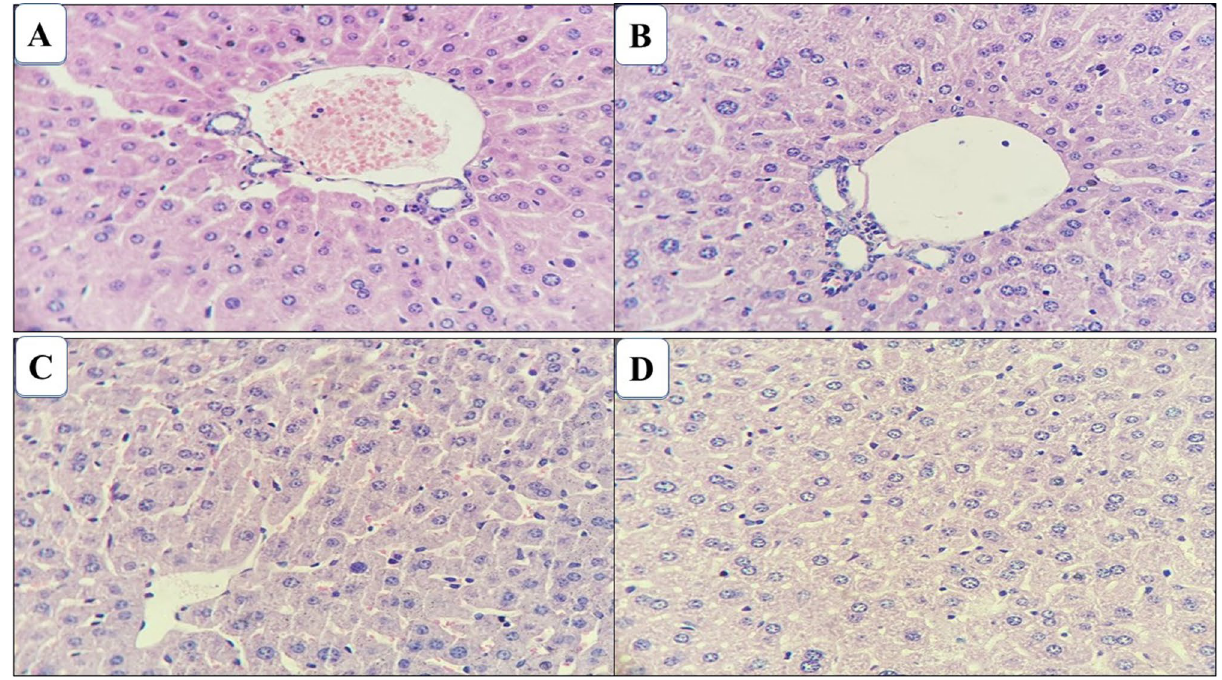
treated with alkaloid fraction; ( D ) control group